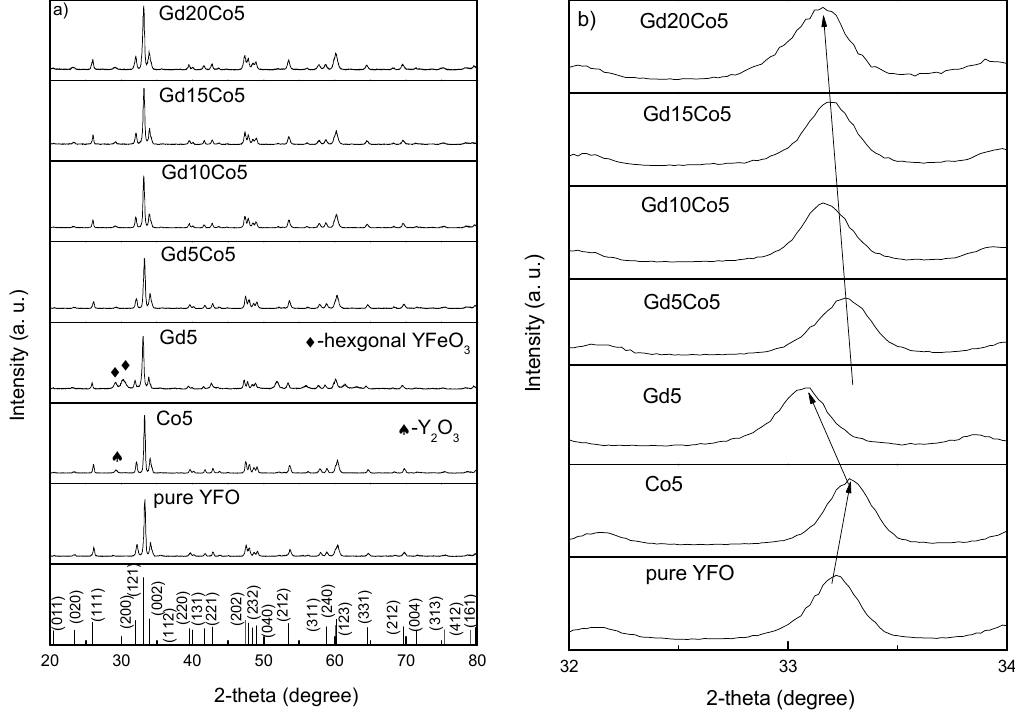
Figure 1. ( a ) XRD patterns of as-prepared nanoparticles calcined at 800 °C; ( b ) the magnified patterns of peaks at 2 θ ~32°. Table 1. Lattice parameters and volume of the samples.